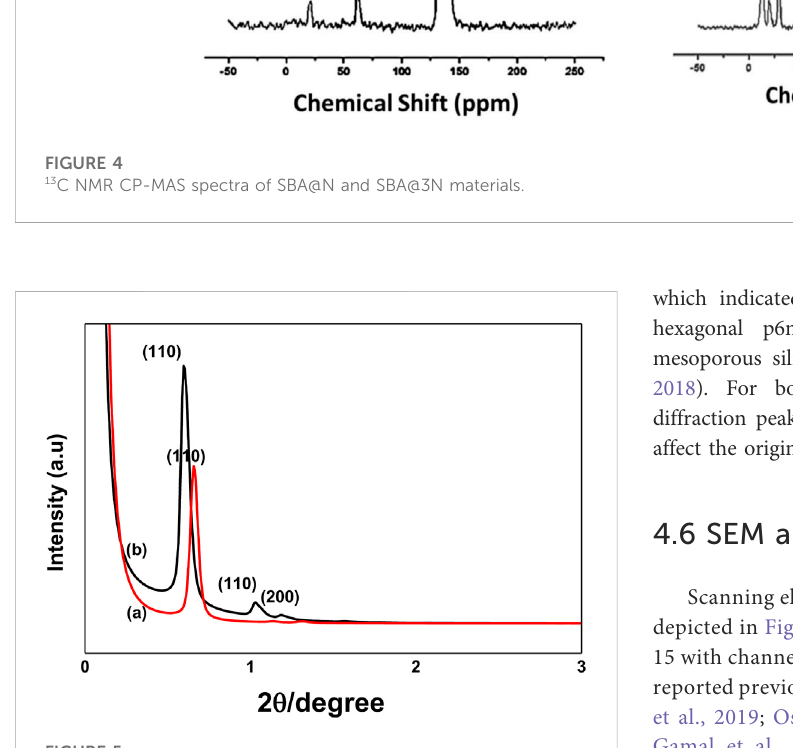
FIGURE 5 Small-angle x-ray diffractograms of (A) SBA@N and (B) SBA@3N silica